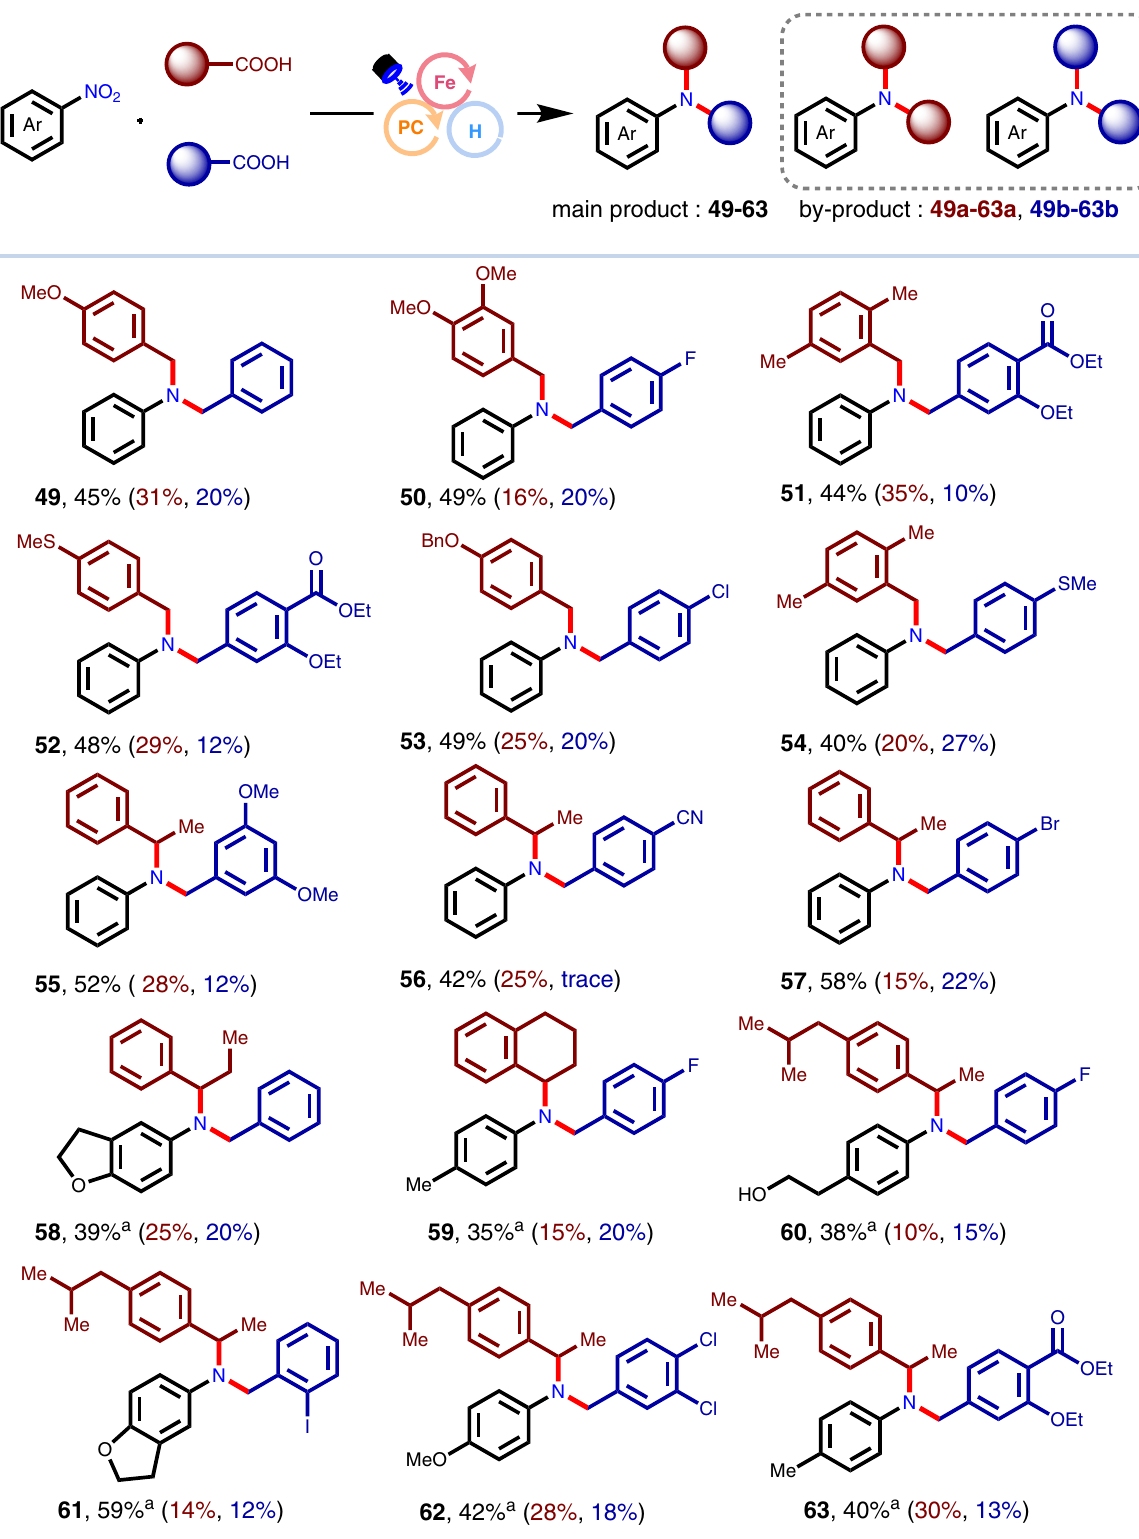
Fig. 3 Representative examples for three-component coupling reactions. Isolated yield (main products: 49 – 63 ; by-products: 49a – 63a , 49b – 63b ) after chromatography were shown in turn. Reaction conditions: 4CzIPN (1 mol%), FeI 2 (10 mol%), L1 (10 mol%), carboxylic acid A (0.3 mmol), carboxylic acid B (0.3 mmol), nitroarenes (0.2 mmol), 2,6-lutidine (3.0 equiv.), (EtO) 3 SiH (2.0 equiv.), MeCN (2 mL), Blue LEDs, 65 °C, 24 h. a Reaction time = 32